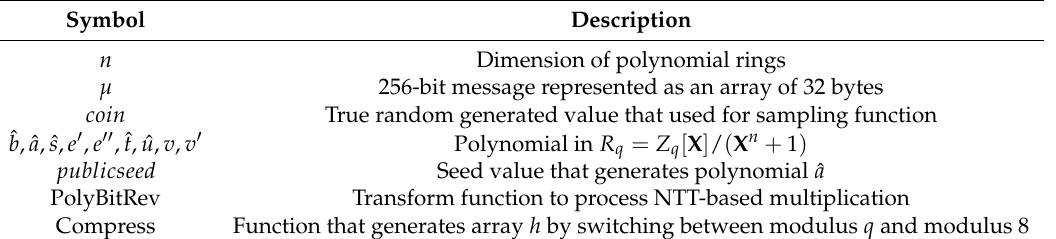
Table 5. Notation of